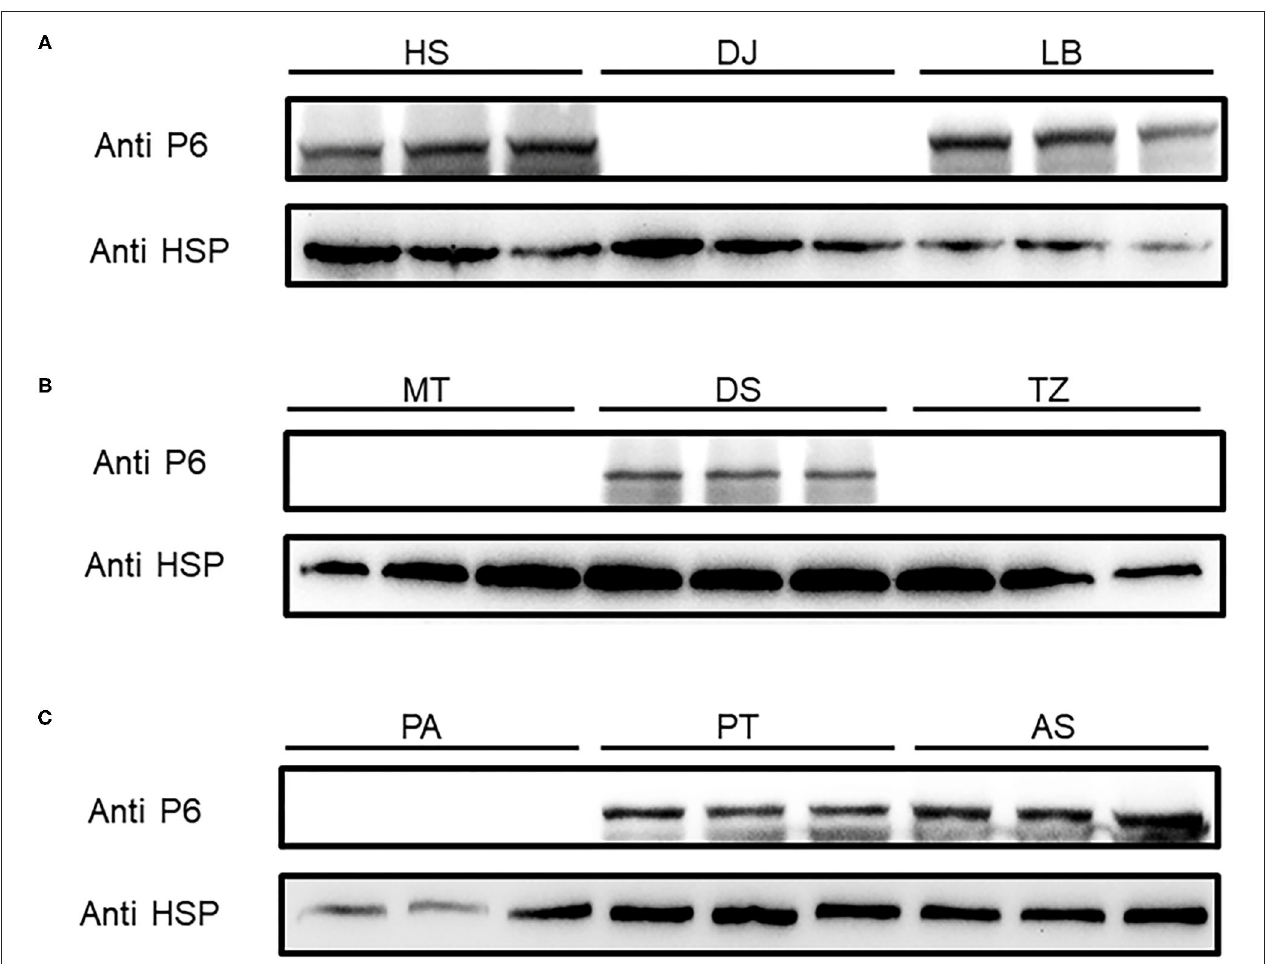
FIGURE 5 | SRBSDV detection in nine districts of Guizhou province. Rice samples from Huishui (HS), Dejiang (DJ), Libo (LB) (A) , Meitan (MT), Dushan (DS), Tianzhu (TZ) (B) , and Puan (PA), Pingtang (PT), and Anshun (AS) (C) were investigated by Western blot. P6 antibody was used to detect SRBSDV, and rice protein HSP90 was used as the internal control.